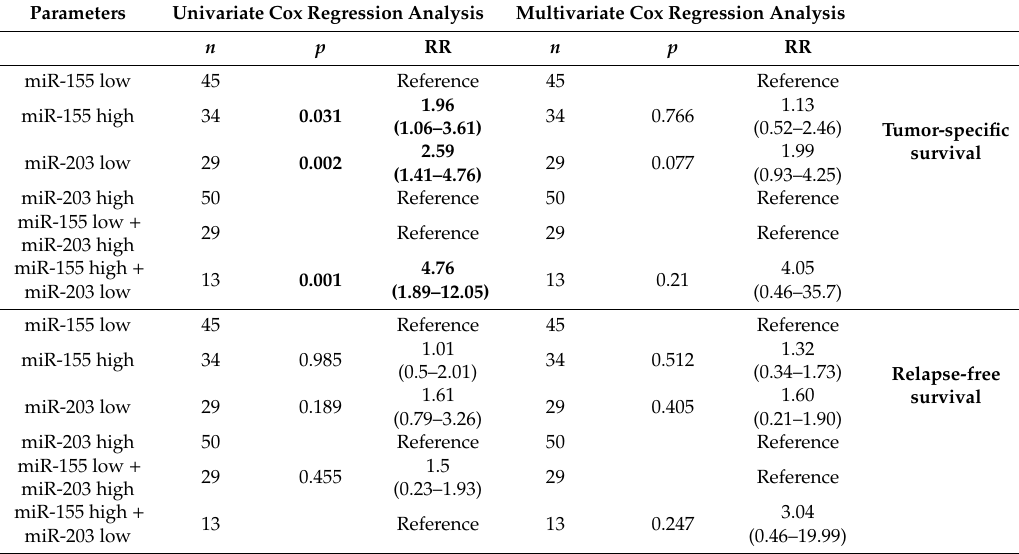
Table 2. Univariate and multivariate Cox regression survival analyses of the impact of miR-155 and miR-203 on soft tissue sarcoma patient survival. Multivariate Cox regression analyses adjusted for tumor stage, resection type, tumor localization and tumor sub-entity. RR = relative risk with 95% confidence interval in